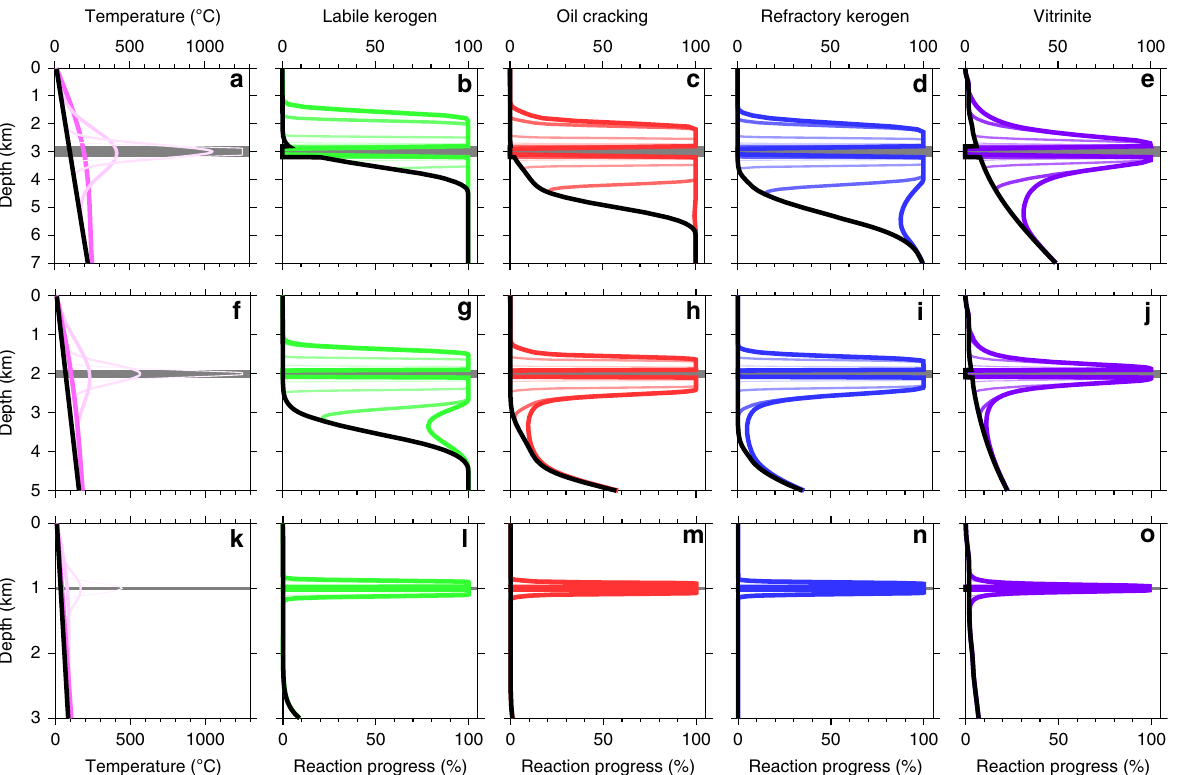
Fig. 2 Modelling hydrocarbon-generating reactions within thermal aureoles of igneous sills. a – e 400-m-thick sill emplaced at 3 km; f – j 200-m-thick sill emplaced at 2 km; k – n 50-m-thick sill emplaced at 1 km. a , f , k Temperature pro fi les immediately before sill intrusion (thick black line) and at times after sill intrusion of 100 years (thinnest line, lightest colour), 1000 years, 10,000 years and 100,000 years (thickest line, strongest colour). All other plots show the same time snapshots using corresponding line thicknesses and colour strengths. b , d , l Reaction progress for labile kerogen maturing to oil. c , h , m Reaction progress for oil cracking to methane. d , i , n Reaction progress for refractory kerogen maturing to methane. e , j , o Reaction progress for vitrinite re fl ectance. The full suite of calculations was done for sill thicknesses of 50, 100, 200, 300 and 400m at emplacement depths of 0.5, 1.0, 1.5, 2.0, 2.5, 3.0 and 3.5